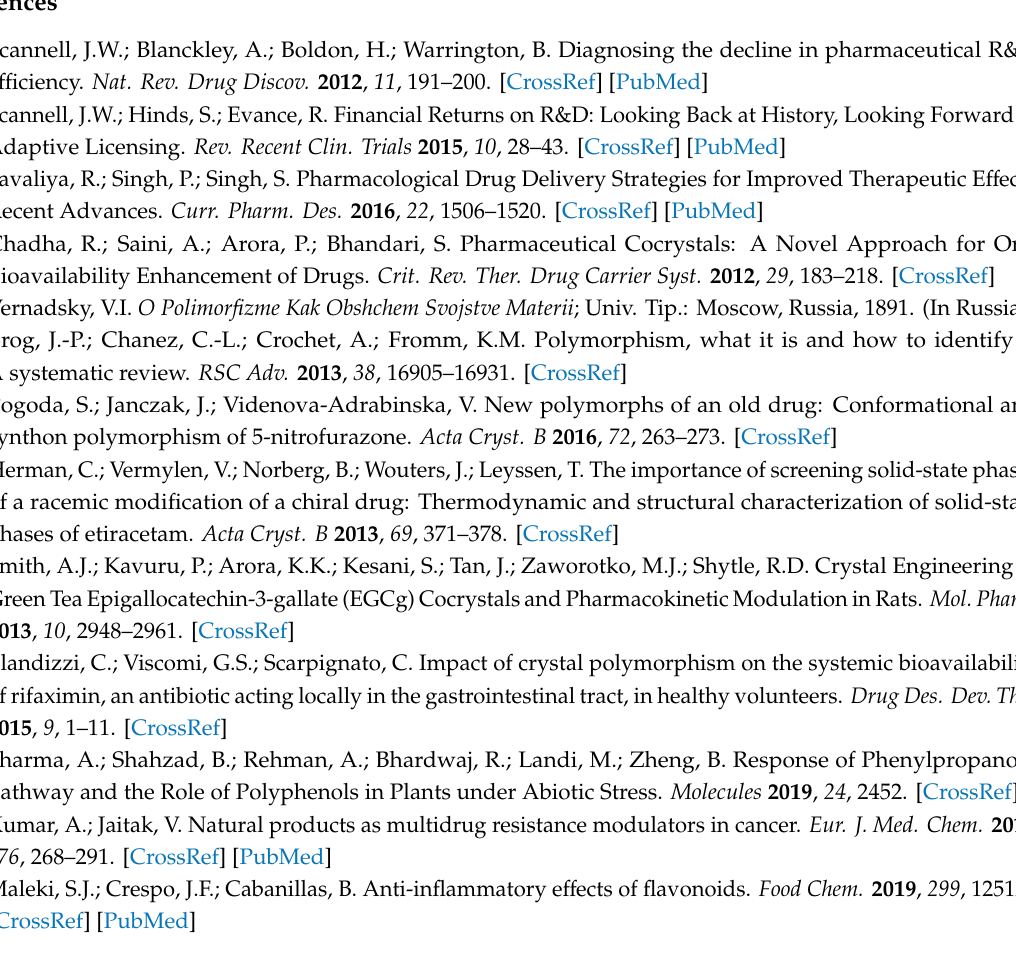
Figure S2: UV spectra of di ff erent taxifolin forms, Figure S3: Mass spectra of di ff erent taxifolin forms, Figure S4: NMR 1 H spectra of di ff erent taxifolin forms, Figure S5: Overlaying plot with DSC curves of di ff erent taxifolin forms, Figure S6: STA-MS patterns of taxifolin forms, Table S1: Interpretation of the NMR 1 H